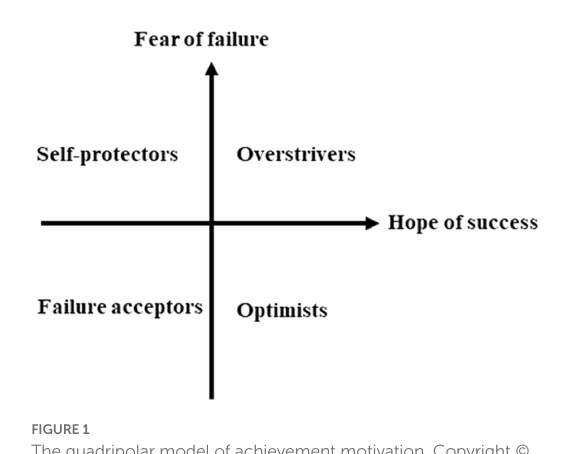
FIGURE 1 The quadripolar model of achievement motivation. Copyright © 2013 by American Psychological Association. Adapted with permission from De Castella et al.